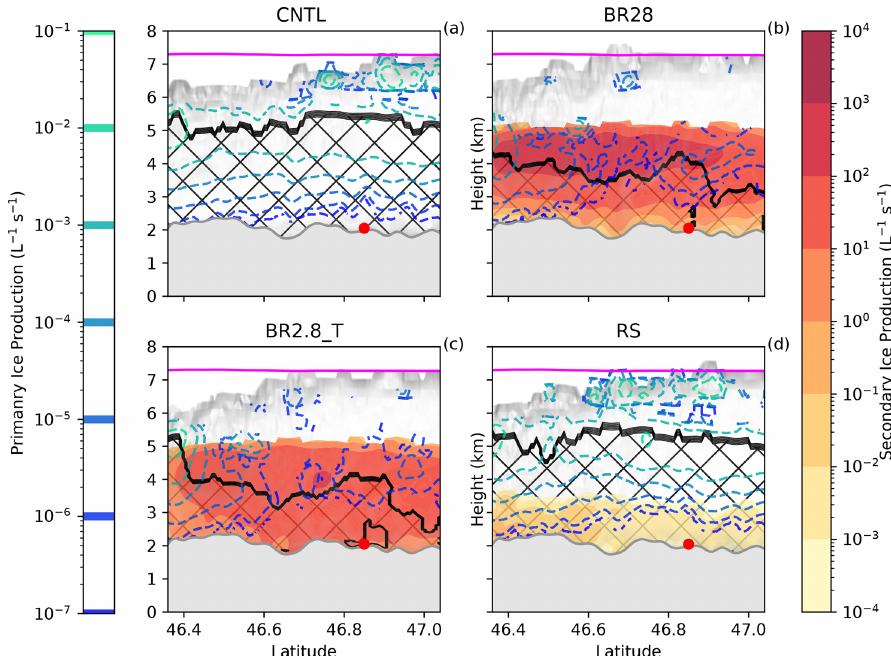
Figure 9. Primary ice production and secondary ice production (per liter per second; hereafter L − 1 s − 1 ) averaged between 12:00 and 14:00UTC for (a) CNTL, (b) BR28, (c) BR2.8_T and (d) RS. The hatched area is defined as the MPC where the cloud droplet mass concentration and ice mass concentration is greater than 10 and 0.1mgm − 3 , respectively. The pink line is the homogeneous freezing line at 235K, and the shaded gray area is the cloud area fraction.